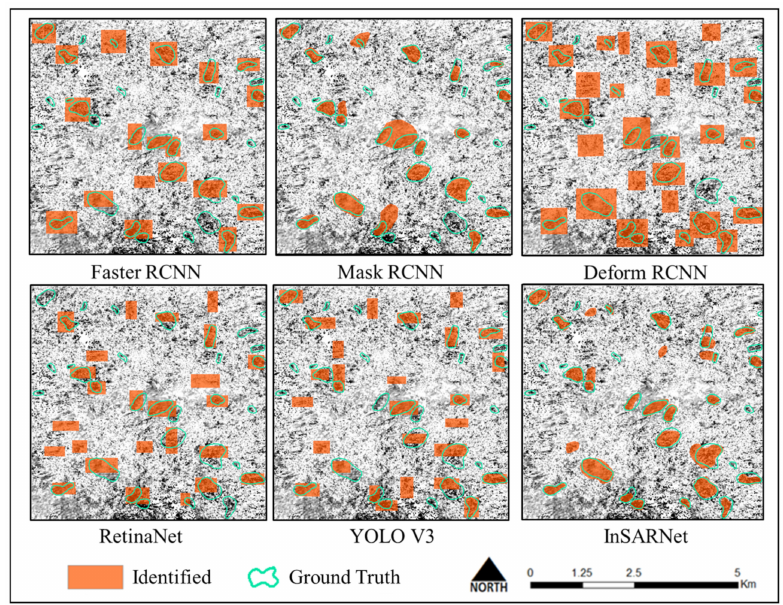
Figure 24. Comparison of different models in test area